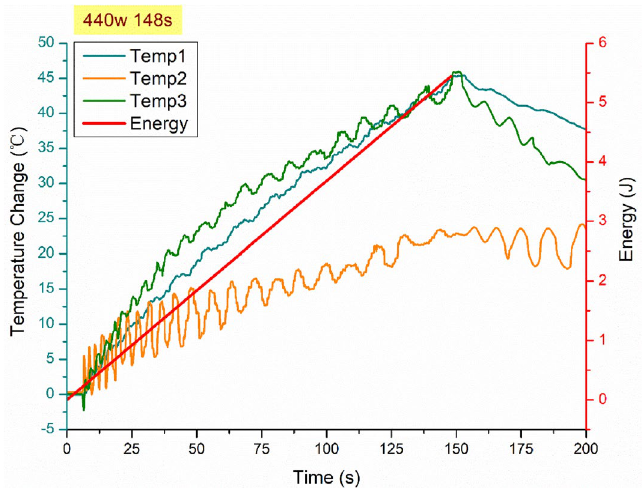
Figure 34. Temperature change measurements (micro-strain) by FBG sensors (left), and energy absorbed (right) versus time (s) under 440